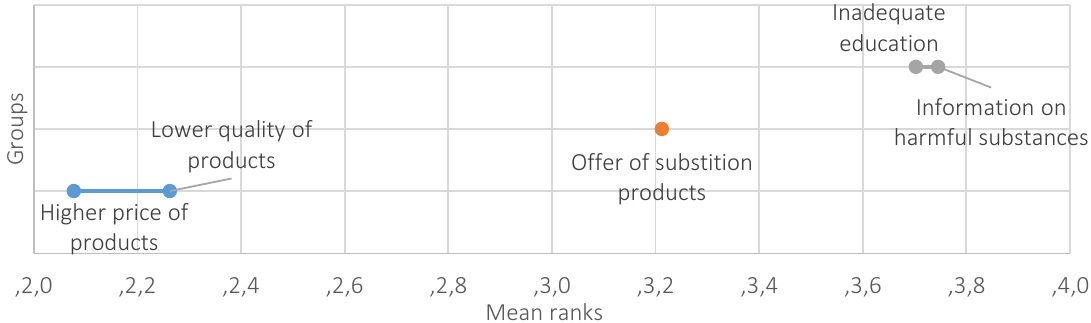
Figure 3. Differences in the assessment of the reasons for low consumption of milk and dairy